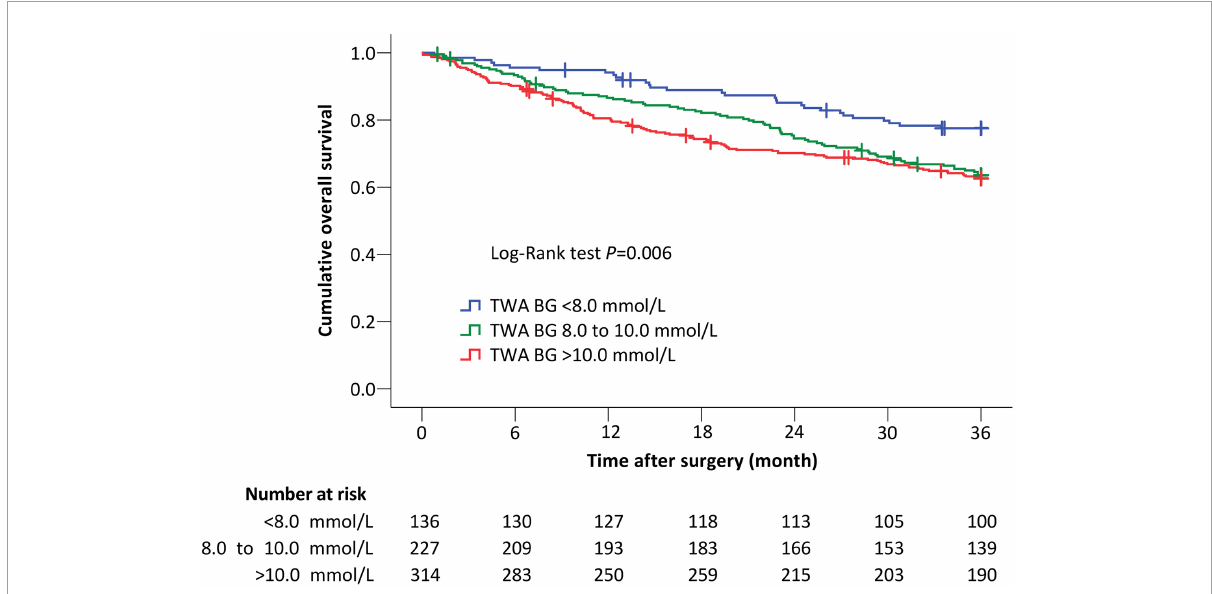
FIGURE2 The Kaplan–Meier curves of overall survival in all patients. When compared with patients with TWA BG < 8.0 mmol/L, the risk of 3-year death remained higher in those with TWA BG 8.0 to 10.0 mmol/L (adjusted HR 2.28, 95% CI 1.47 to 3.54, P < 0.001) and with TWA BG > 10.0 mmol/L (adjusted HR 2.00, 95% CI 1.29 to 3.10, P = 0.002) after adjustment for confounding factors including age, sex, body mass index, chronic smoking, history of type II diabetes mellitus, American Society of Anesthesiologists classification, preoperative Barthel Index, preoperative hemoglobin, preoperative albumin, tumor-node-metastasis stage, type of anesthesia, site of surgery, Operative Stress Score, duration of surgery, intraoperative blood transfusion, endotracheal intubation on ICU admission, delirium within 7 days, and non-delirium complications within 30 days. Crosses indicate censored patients. TWA BG, time-weighted average blood